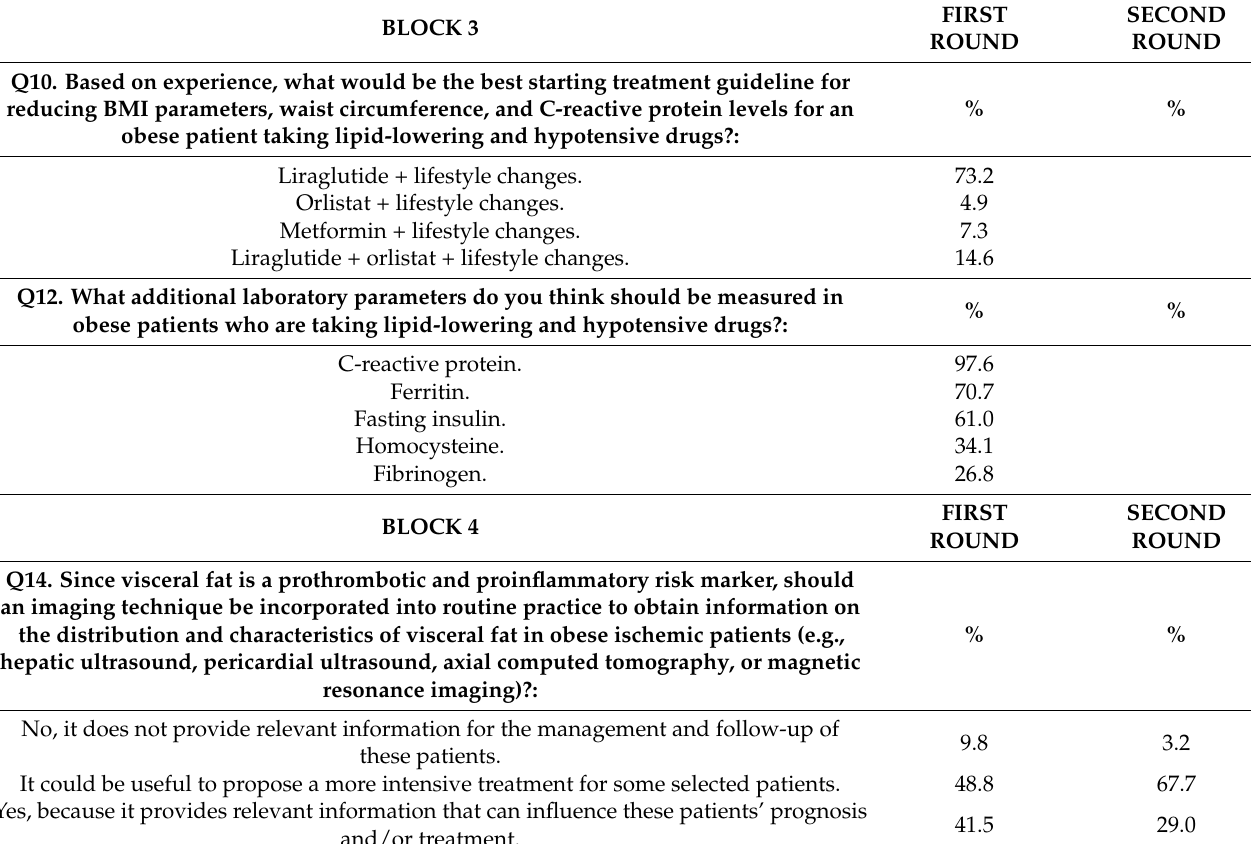
Table 2. Categorical response